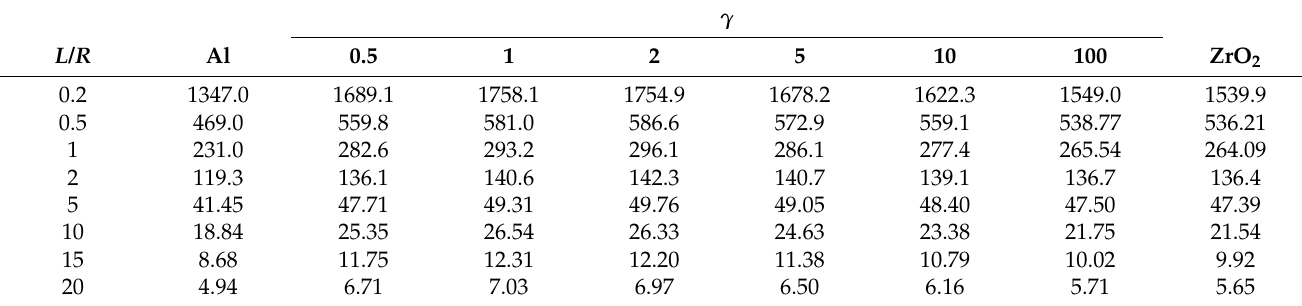
Table 4. Variations of the fundamental frequencies (Hz) with the power-law exponent and length to radius ratio ( L / R ). γ